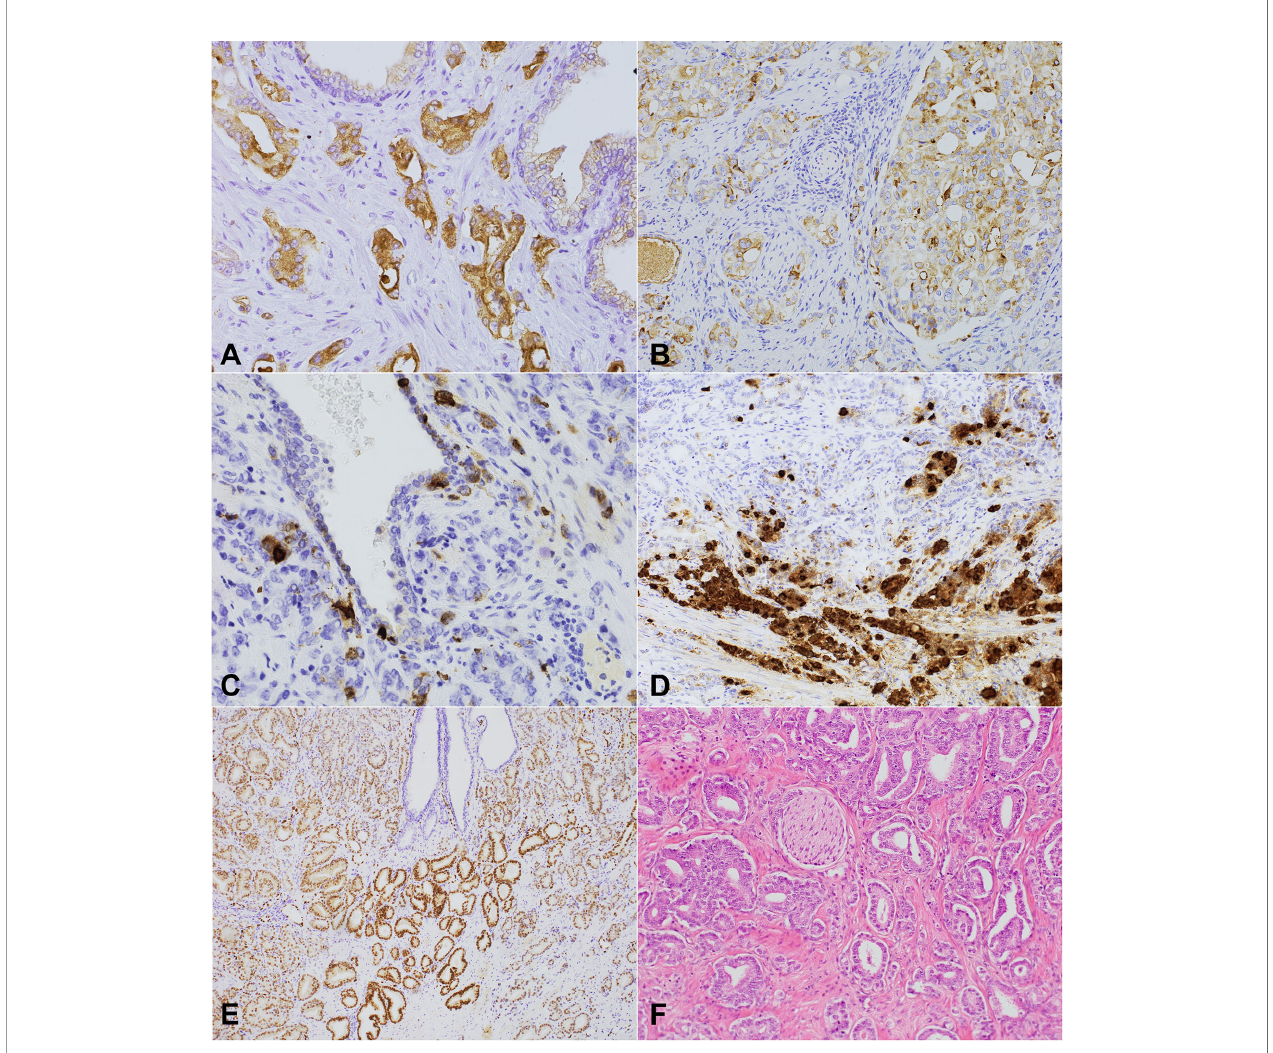
FIGURE 2 | NPY, chromogranin, and (NPY, 400x) ERG expression and perineural invasion in prostate cancer. (A, B) Cytoplasmic-membranous NPY expression in neoplastic glands. (A) Strong expression score (2). (B) 200x Heterogenous intermediate NPY expression score and membranous apical immunostaining within the preexistent prostate glands (NPY, 200x). (C) Chromogranin – a strongly positive scattered single cell pattern (chromogranin, 400x). (D) A high level of neuroendocrine differentiation within PCa (chromogranin). (E) Nuclear ERG expression with diverse intensity within the cancer cells, positive endothelial cells, and immunonegative benign prostatic glands (ERG, 100x). (F) A histological section of prostate cancer with focal perineural invasion and other invisible neural components of the microenvironment (HE,